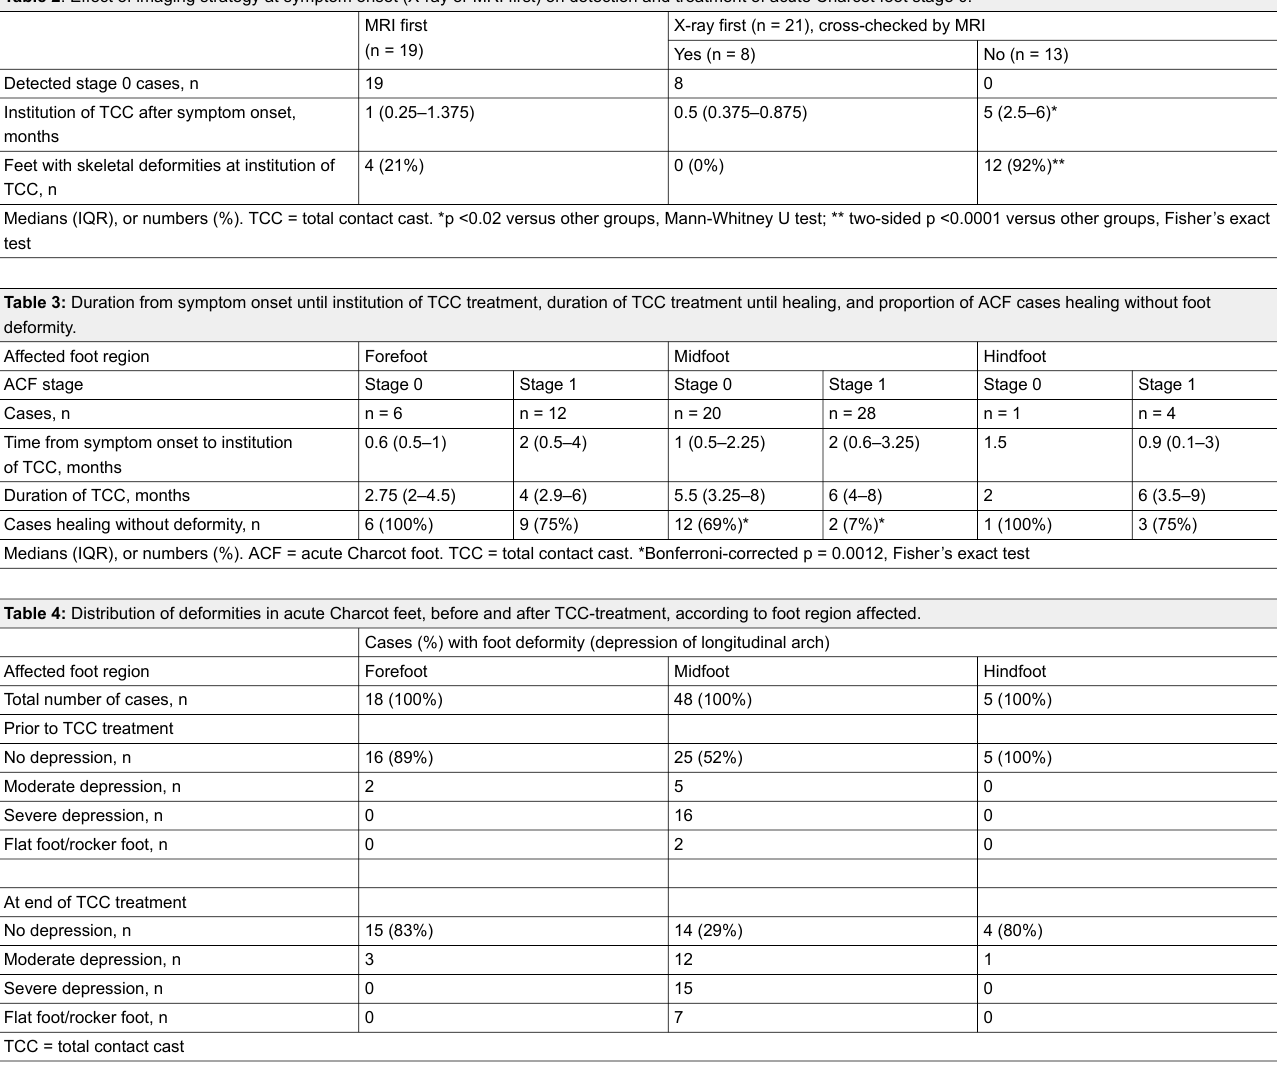
Table 2 : Effect of imaging strategy at symptom onset (X-ray or MRI first) on detection and treatment of acute Charcot foot stage 0. X-ray first (n = 21), cross-checked by MRIMRI first (n = 19) Yes (n = 8) No (n = 13) Detected stage 0 cases, n